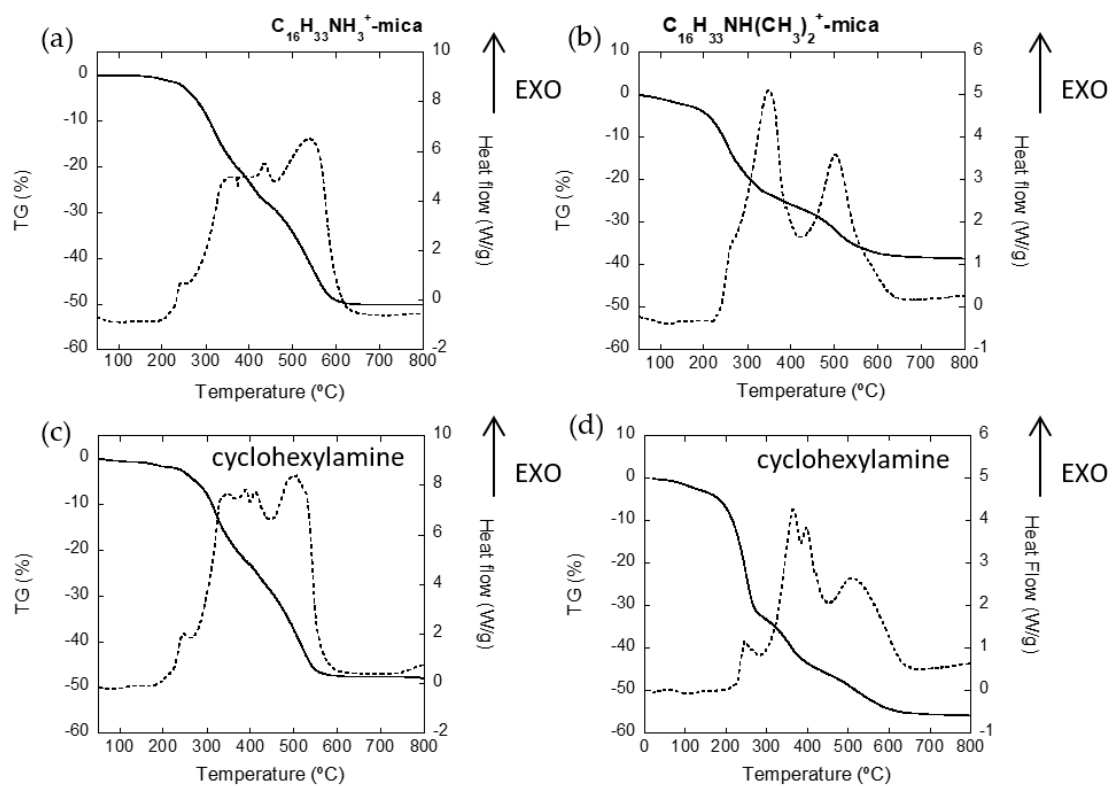
Figure 2. TG (solid line) and DSC (dashed line) plots for C 16 H 33 NH 3+ -mica ( a ), C 16 H 33 NH(CH 3 ) 2+ -mica ( b ) and the samples after cyclohexylamine adsorption ( c , d ).